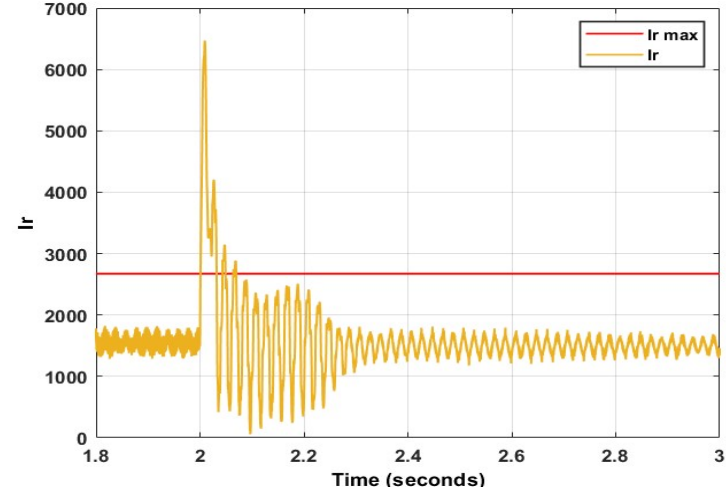
Figure 11. Rotor current transient using AVOA at 70% dip.